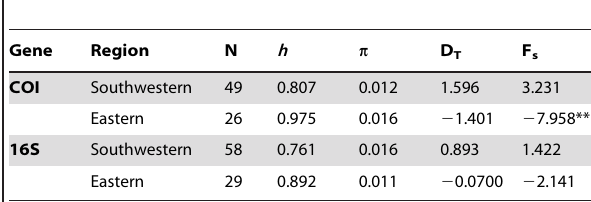
Table 4. Summary of regional genetic parameters for regions with multiple undifferentiated populations, including values of nucleotide diversity ( p ), Tajima’s D T and Fu’s F s